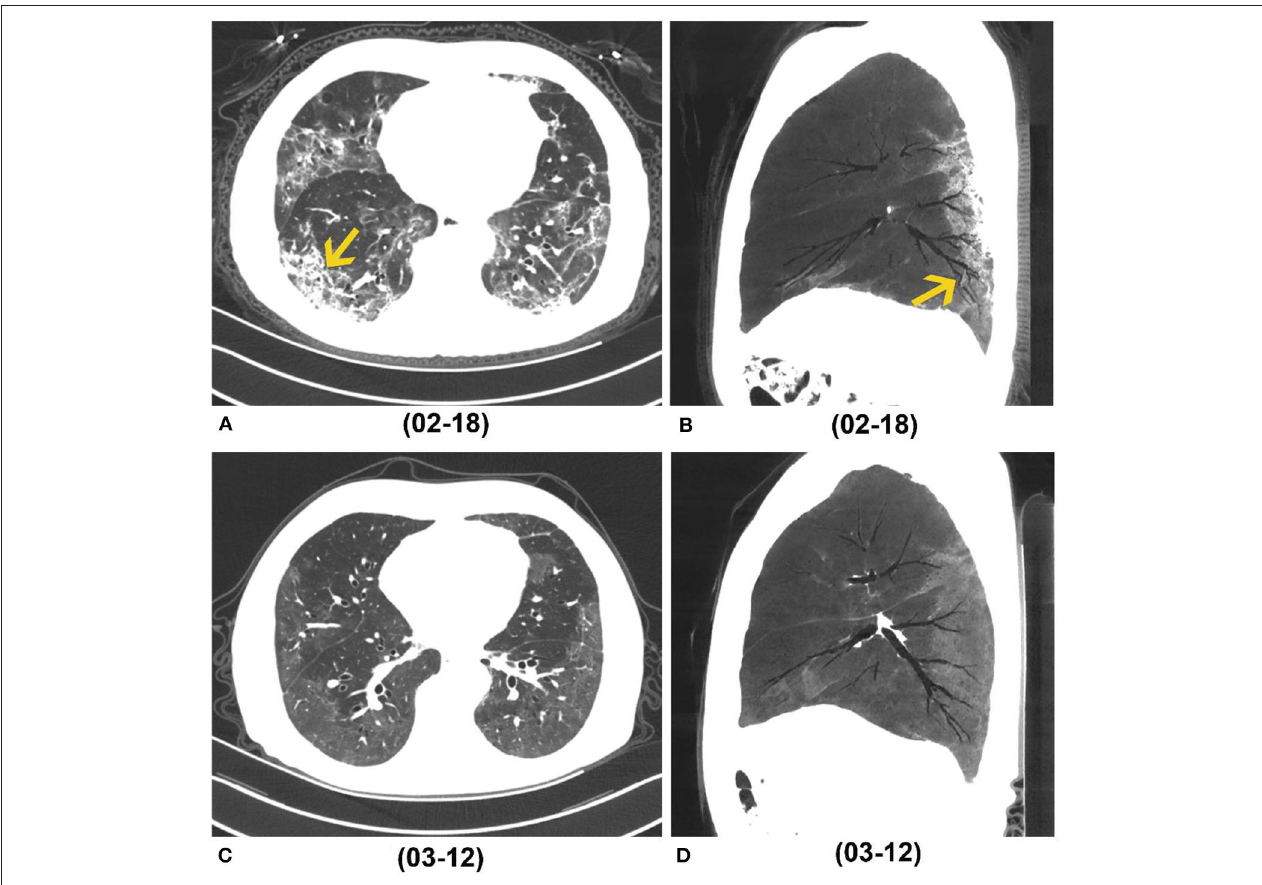
FIGURE 4 | A 68-year-old man who caught a fever and cough on January 17, 2020. (A,B) Axial and sagittal CT (Min IP) performed on February 18 (peak CT, 32 days after symptoms onset) showed GGO, reticulation (yellow arrow in A) and bronchial distortion (yellow arrow in B) in the bilateral lungs. (C,D) Axial and sagittal CT (Min IP) performed on March 12 (last follow-up CT, 55 days after symptoms onset) showed residual GGO, while previous reticulation and distortion disappeared. Min IP, minimum intensity projection; COVID-19, coronavirus disease 2019; GGO, ground-glass